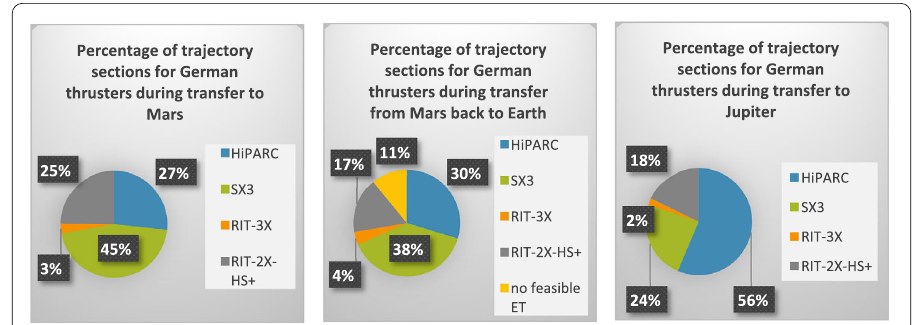
Figure 3 Percentages of trajectory sections for the cluster with German thrusters